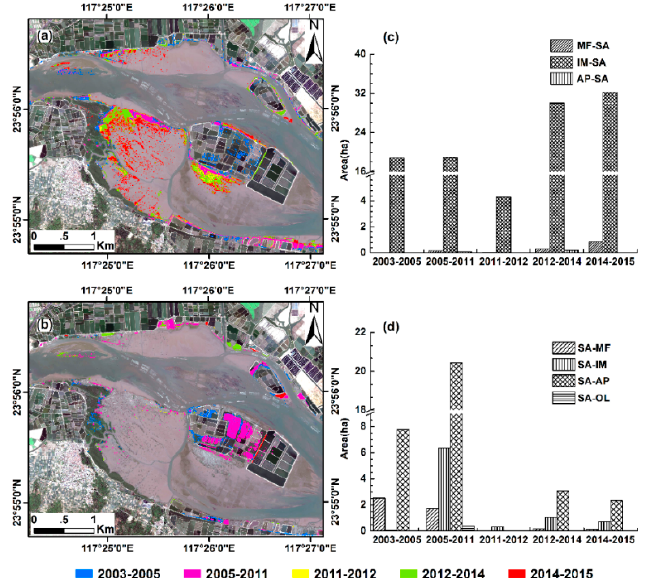
Figure 4. Gain and loss of S. alterniflora and their conversions in different periods from 2003 to 2015. ( a ) displays the gains of S. alterniflora in different stages from 2003 to 2015; ( b ) shows the losses; ( c ) displays the conversion from other land cover types into S. alterniflora ; and ( d ) shows the opposite transformation.